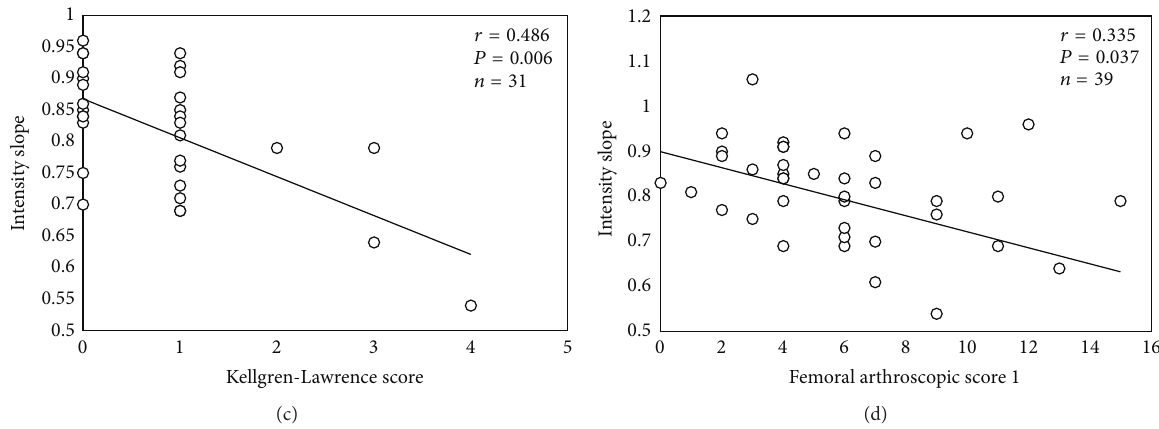
Figure2:(a)Relationshipbetweennormalizedmeanintensityvaluesoffemoralbonelevel2andKellgren-Lawrence(K-L)gradingorfemoral arthroscopic score 1 (FAS1) (b). Relationship between femoral subchondral bone intensity slope and K-L grading (c) or FAS1 (d). The slope was calculated from the first 2 levels. Please note that the trendline in each plot is only for illustration